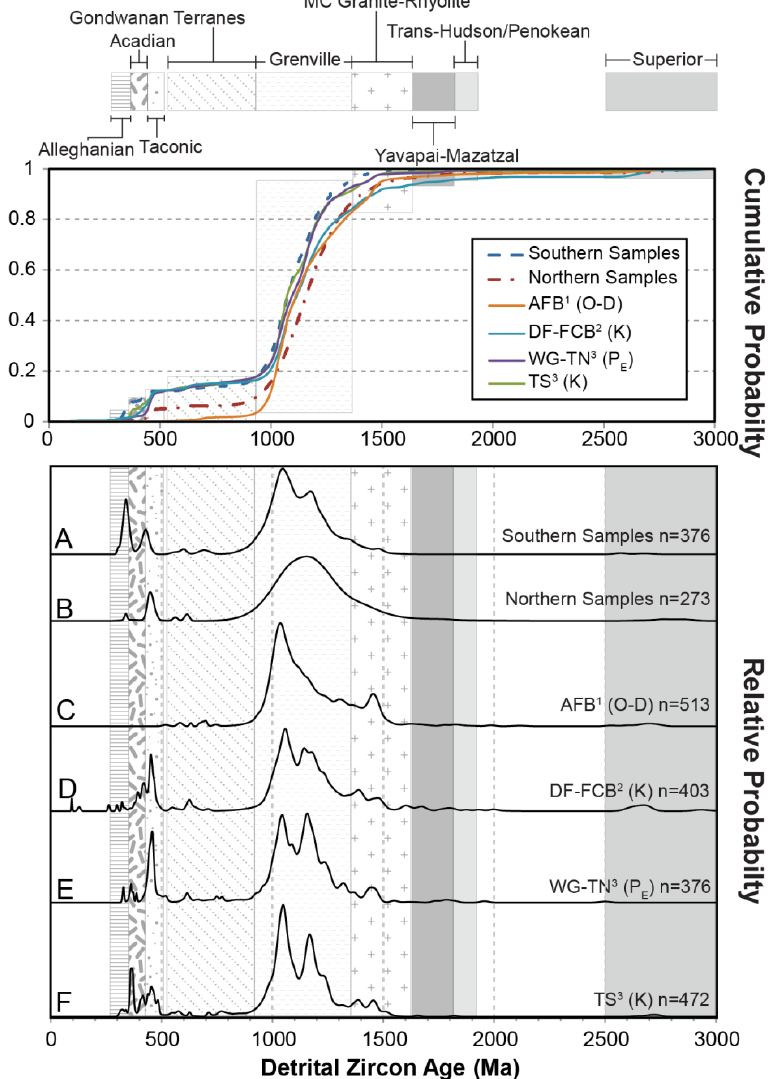
Figure 11. Stacked cumulative and normalized age-probability plots of detrital zircon from ( A ) SS, ( B ) NS, ( C )OrdovicianandDevonianstrataintheAppalachianForelandBasin(AFB); 1 [50]),( D )Cenomanian–Albian Dakota Fm from the FCB; 2 [17]), ( E ) Paleocene Wilcox Group strata from Tennessee (WG–TN); 3 [1], ( F ) Cenomanian Tuscaloosa Sandstone (TS). Potential source regions are shown as vertical bars. Samples shown have K–S statistical p -values > 0.05 when compared to either the SS or